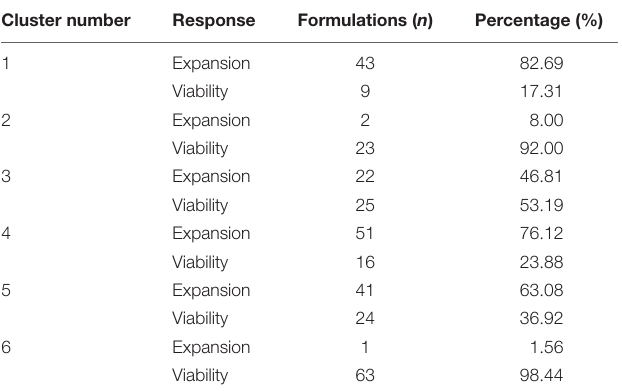
TABLE 2 | Number and proportion of media formulations within the